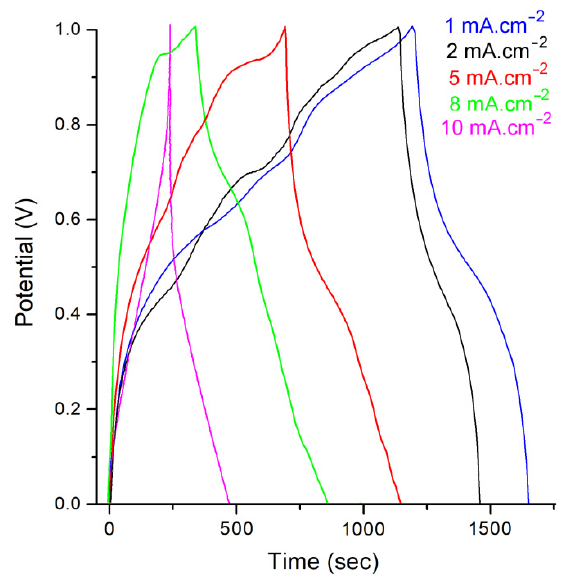
Figure 10. Galvanostatic charge–discharge (GCD) curves of the PANI@TiO 2 –CuO electrode at different current densities.